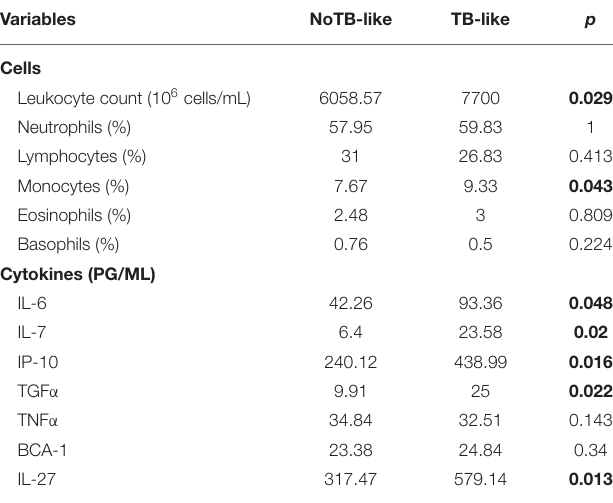
TABLE 3 | Immunological variables in TB-like and NoTB-like